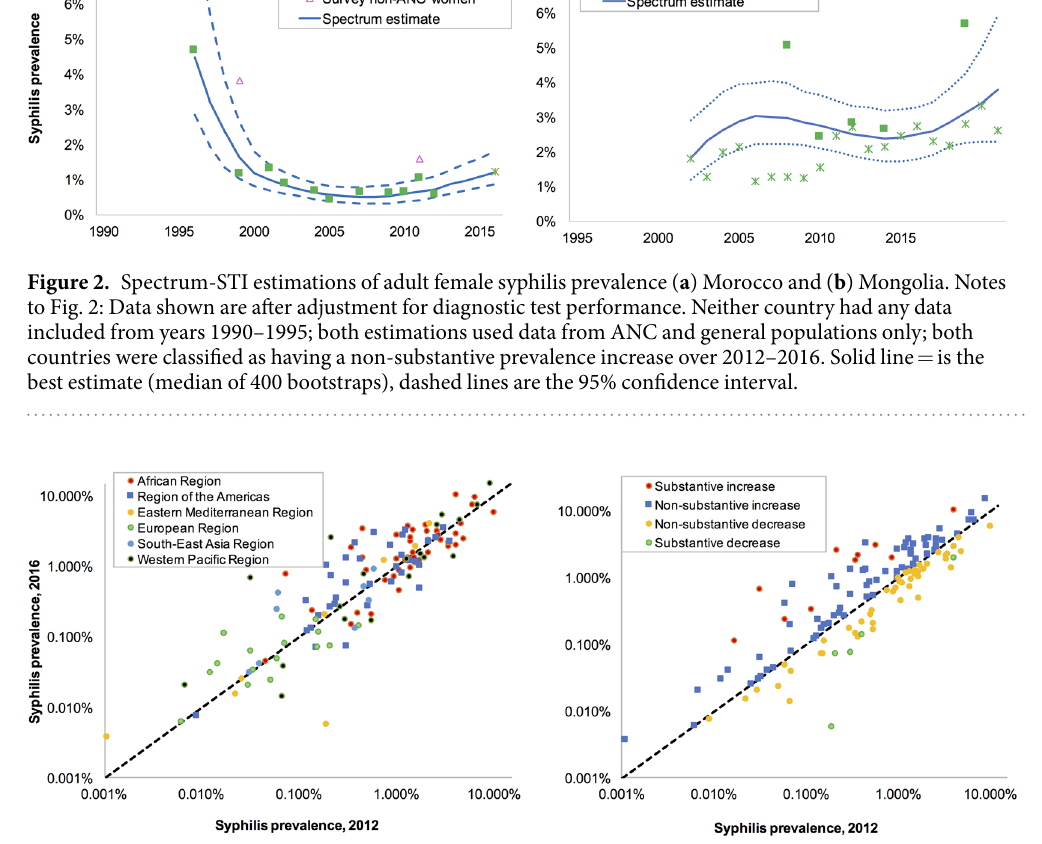
Figure 3. Spectrum-estimated national syphilis prevalence in 2016 as a function of estimated prevalence in 2012, and each country’s time trend classification, for 132 countries: ( a ) Grouped by WHO region. ( b ) Grouped by time trend category. Notes to Fig. 3: The black dotted line indicates equality of prevalence within a country at 2012 and